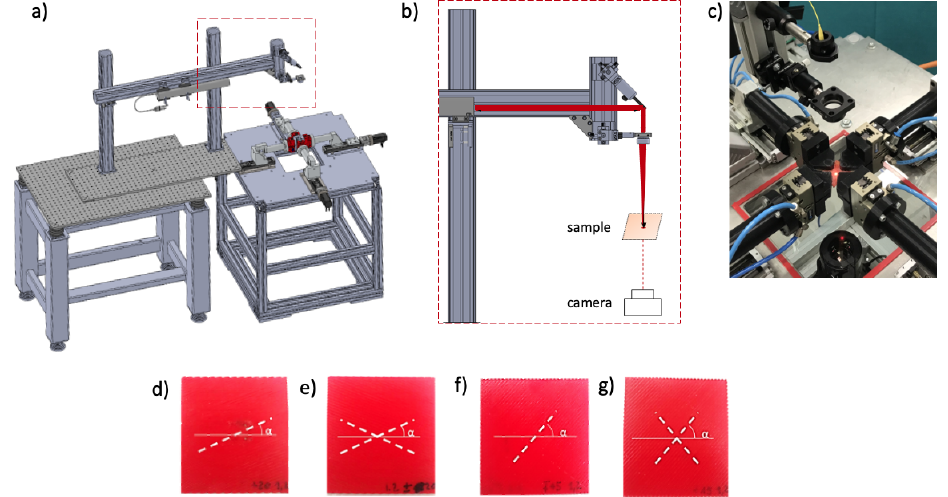
Figure 3. ( a , b ) CAD models for the experimental Small Angle Light Scattering (SALS) setup with ( c ) highlight on the laser head. 3D printed specimens with different in fill angles: ( d ) α 1 = 20 ◦ , ( e ) α 1,2 = ± 20 ◦ , ( f ) α 1 = 45 ◦ and ( g ) α 1,2 = ± 45 ◦ .